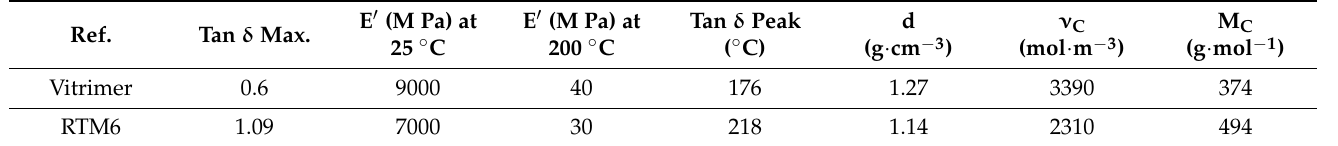
Figure 1. DMA curve obtained for epoxy vitrimer, representing storage modulus (E ′ ), loss modulus (E ″ ), and tan delta versus temperature. Tg = 176 °C was determined from the maximum of tan delta . Table 1. Tan δ , E ′ , E ″ , Density, ν C, and M C of aero grade epoxy vitrimer and reference RTM 6 apply- ing rubber elasticity theory.